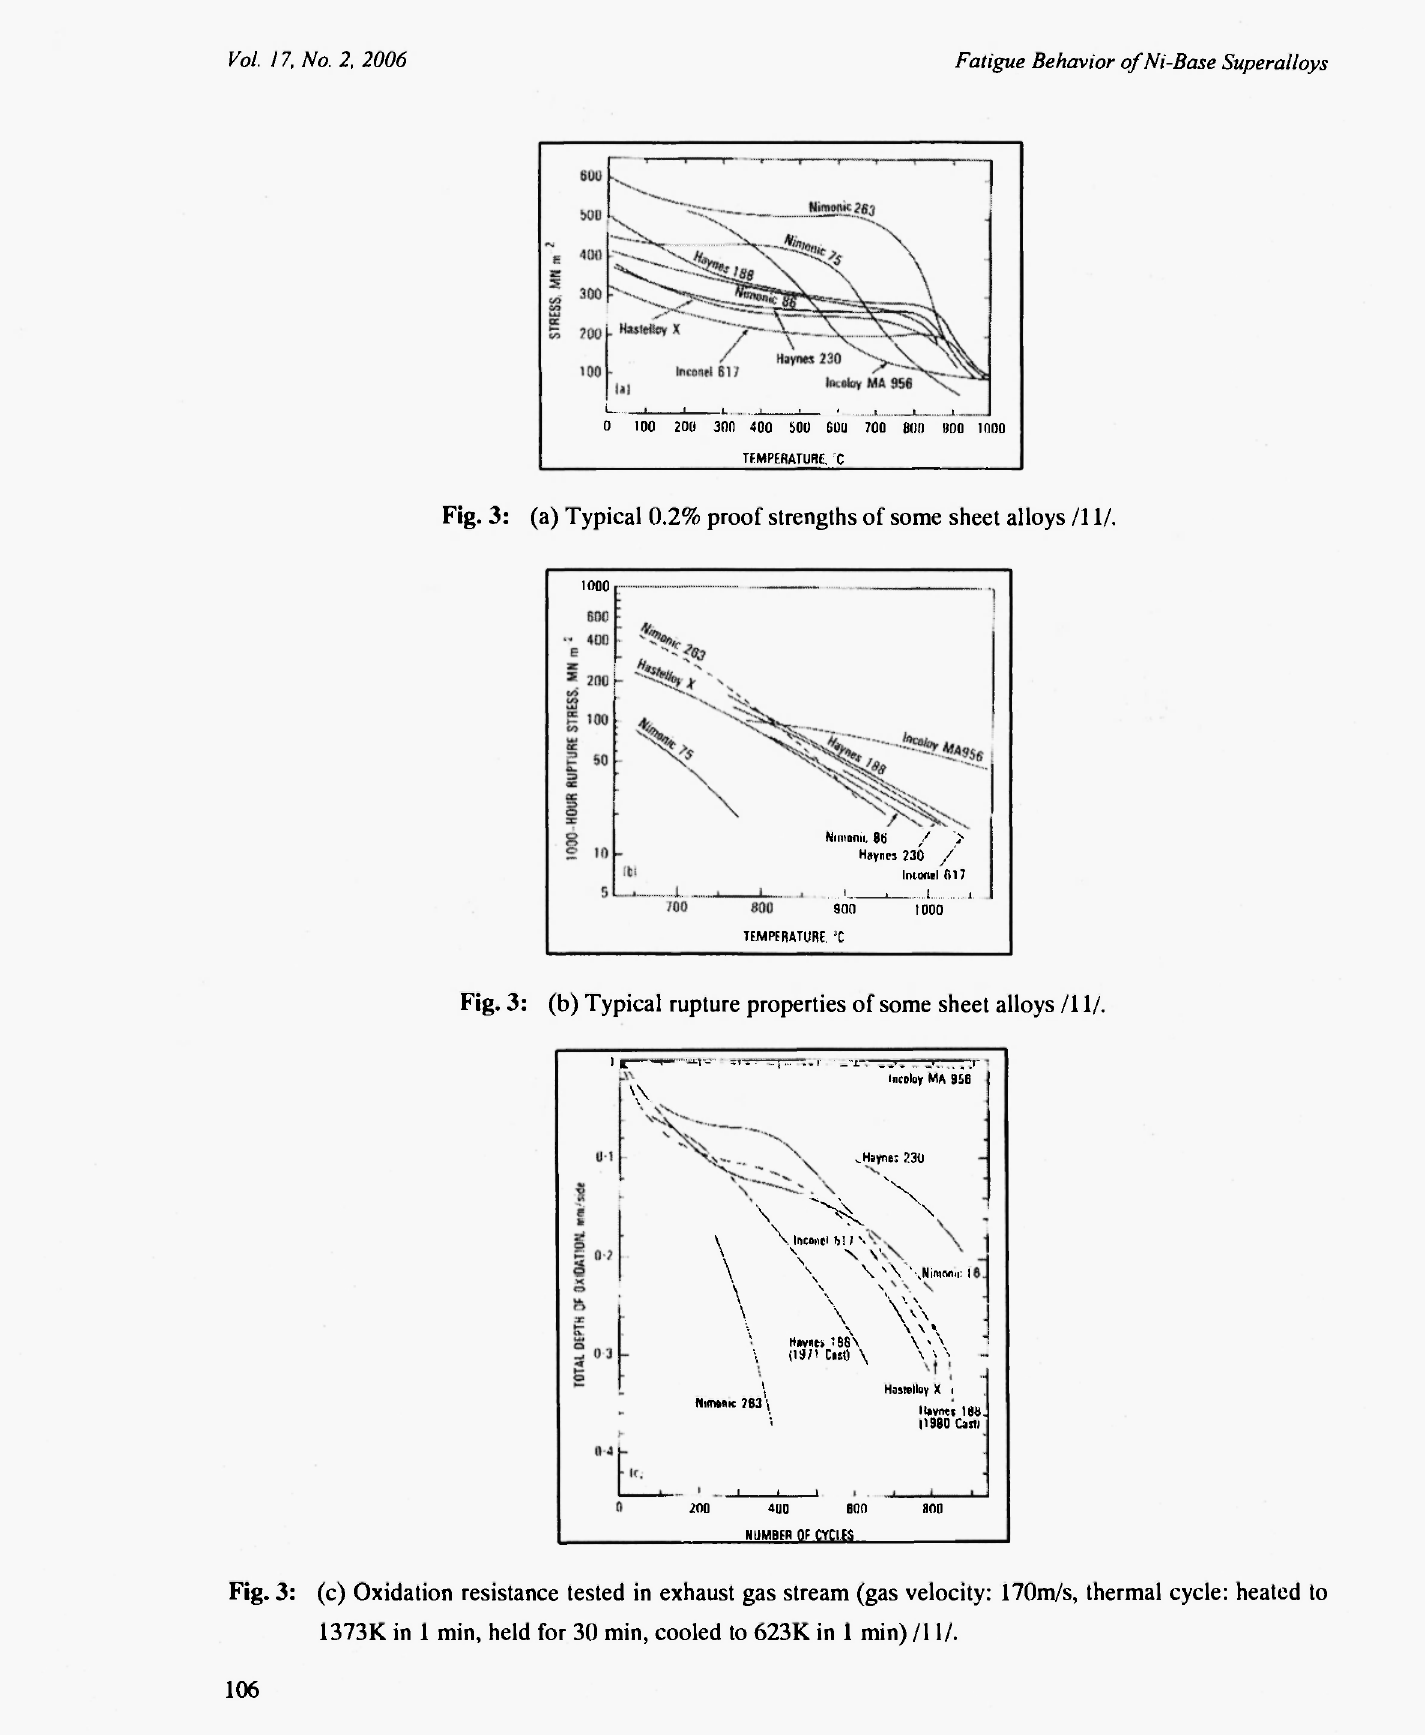
(c) Oxidation resistance tested in exhaust gas stream (gas velocity: 170m/s, thermal cycle: heated to 1373K in 1 min, held for 30 min, cooled to 623K in 1 min) /ll/.